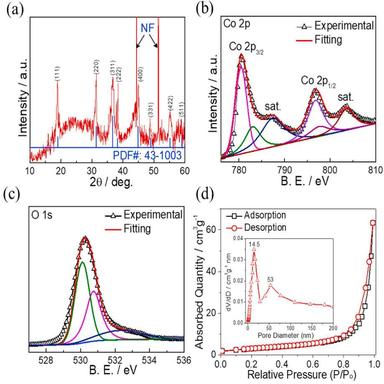
(a) XRD pattern, (b–c) XPS spectrums of Co2p and O 1s, (d) N2 adsorption/desorption curves (Inset shows the pore-size-distribution measurements) of Co3O4@NF-16h sample.